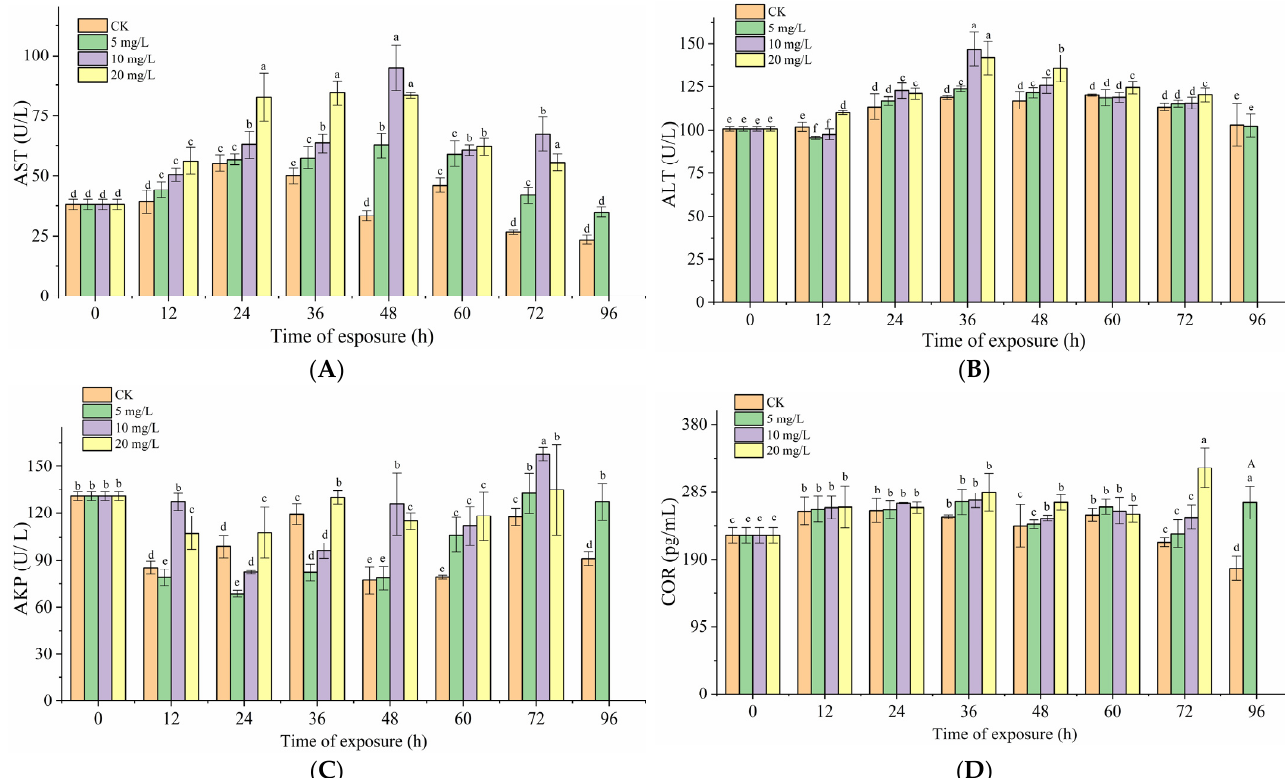
Figure 1. Changes in serum ( A ) AST, ( B ) ALT, ( C ) AKP, and ( D ) COR levels in pearl gentian grouper exposed to various nitrite concentrations over 96 h. Data are means ± SD. Different lowercase letters indicate that there are significant differences among groups ( p < 0.05).